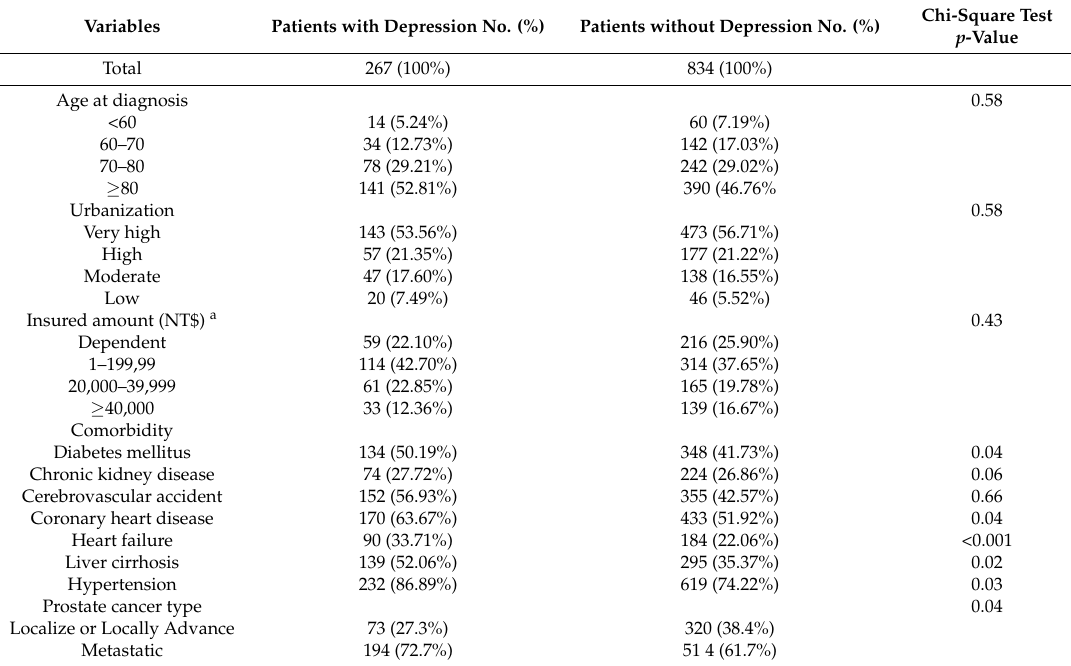
Table 1. Demographic and medical characteristics of prostate cancer patients according to depression.